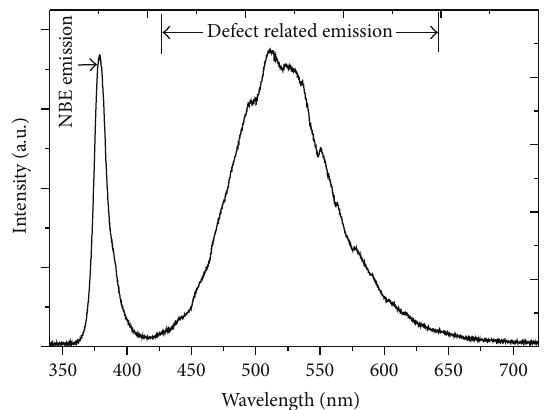
Figure 9: The room temperature PL spectrum of the ZnO NRs grown on stainless steel